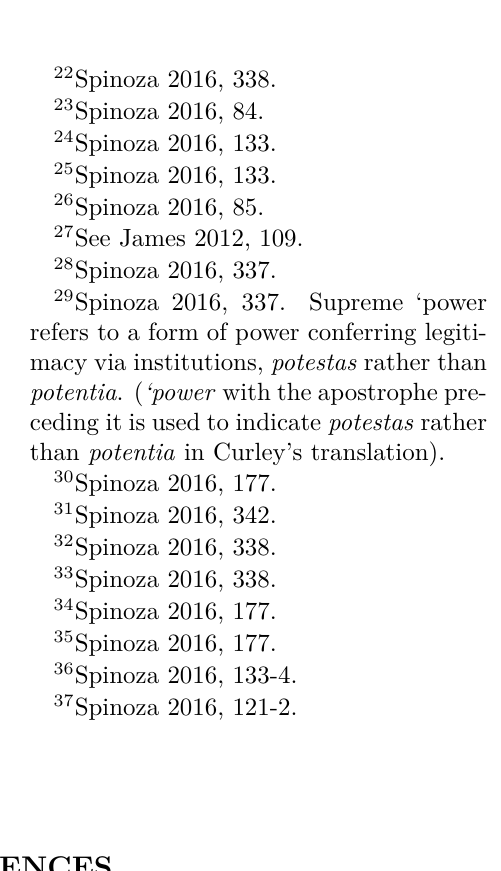
refers to a form of power conferring legiti- macy via institutions, potestas rather than potentia . ( ‘power with the apostrophe pre- ceding it is used to indicate potestas rather than potentia in Curley’s